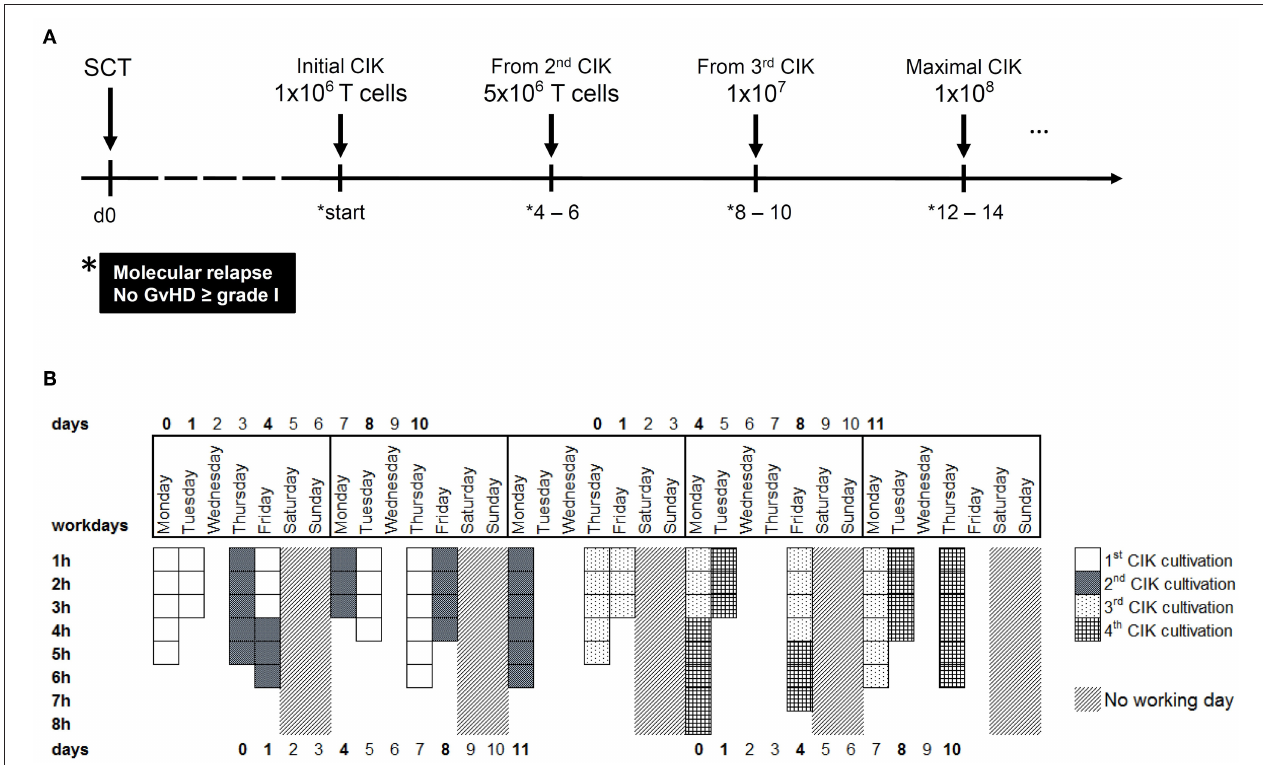
FIGURE 1 | CIK cell generation within the clinical phase I/II study. (A) CIK cells are administered to patients with molecular relapse defined as mixed chimerism ≥ 1% of recipient (autologous) signals; detectable MRD ≥ 10 − 6 or BCR-ABL/ABL ≥ 10 − 4 . According to ATMP § 4b license, repeated CIK cell applications with escalating doses may be provided to patients suffering from prolonged molecular relapse in intervals of 4–6 weeks under the condition that no GVHD ≥ grade I occurred. (B) Within a time-frame of 5 weeks, four different batches of CIK cells can be manufactured. The working days and the estimated time for tasks like initiation, cytokine stimulation or harvest are